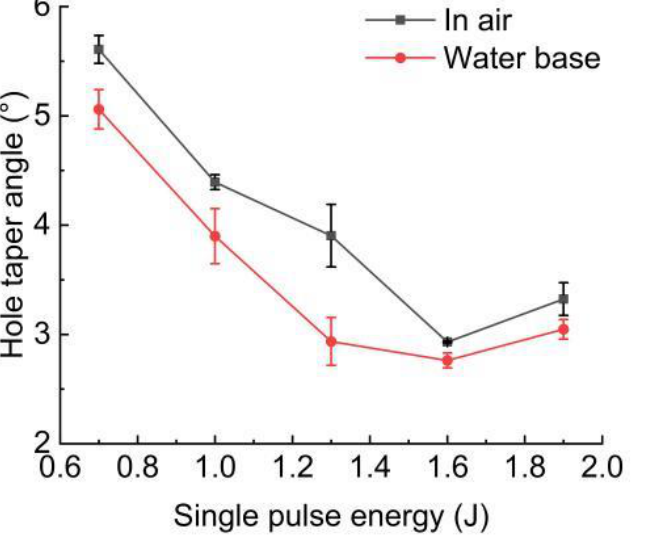
Figure 8. Effect of pulse energy on the morphology of hole cross-section: ( a ) in air, ( b ) water-based.